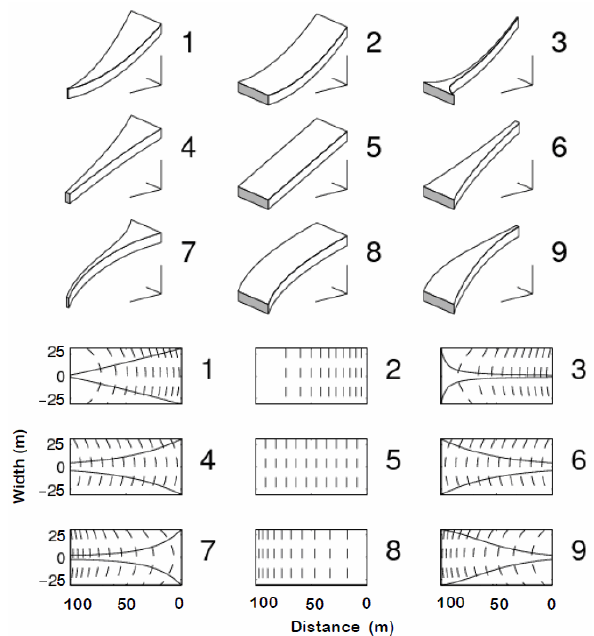
Fig. 2. A three-dimensional view (top) and a two-dimensional plot of the contour lines and slope divides (bottom) of the nine hillslopes considered in this study (after Hilbert et al., 2004).